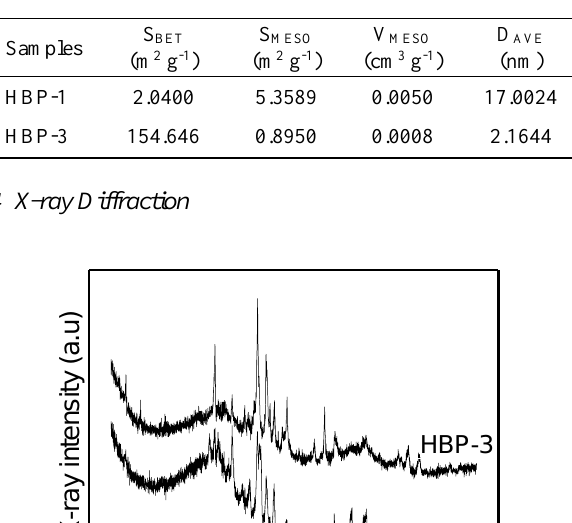
Fig. 3. The N 2 adsorption/desorption isotherms: (a) HBP-1; (b) HBP-3. Table 2. Textural properties of monolithic activated carbon from HBP-s